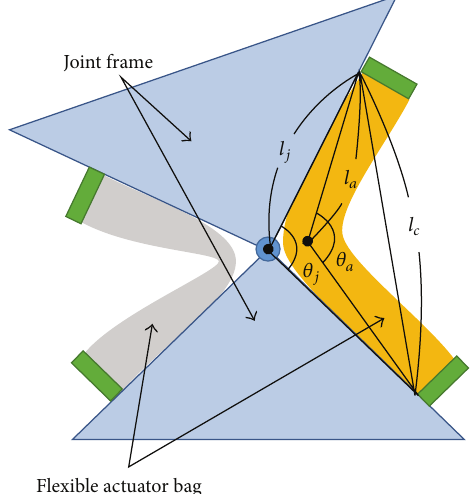
Figure 5: Geometry of the joint and actuator bags.